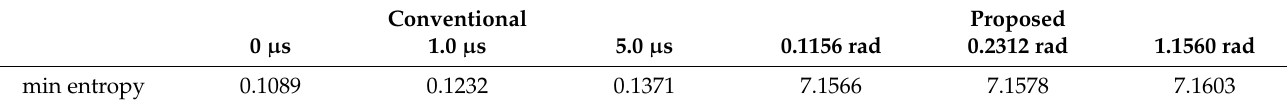
Table 6. NIST SP 800-90B test